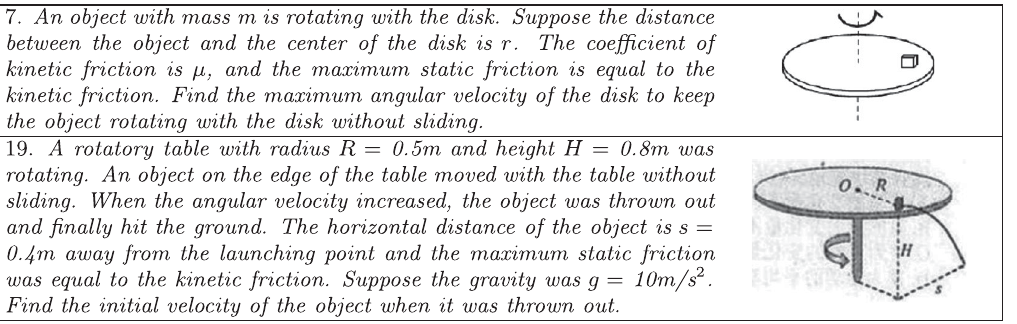
FIG. 1. Q7 and Q19 in the questionnaire. The category of rotational kinematics was considered good for Q7. However, the same category was evaluated as poor for Q19 because Q19 was actually a question about projectile motion, and the information about circular motion made no contribution to solving this problem.